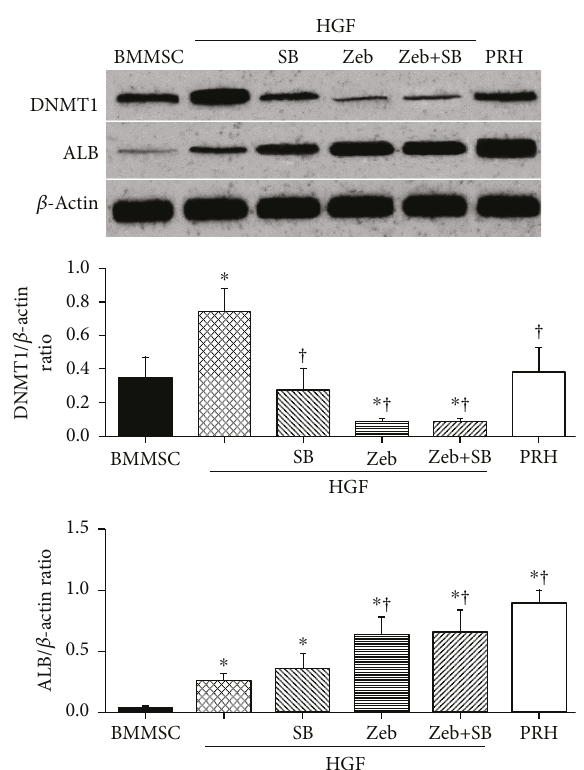
Figure 4: Zebularine and SB203580 inhibited expression of DNMT1 and upregulated expression of ALB in BMMSCs. Noninduced BMMSCs and primary rabbit hepatocytes (PRH) were used as negative or positive controls. HGF increased the expression of DNMT1. HGF-induced expression of DNMT1 was inhibited by zebularine and SB203580. ALB protein expression was regulated by SB203580 and zebularine. The peak of expression of ALB in the induced groups was lower than that in primary rabbit hepatocytes. Asterisk indicates p < 0 05 compared with the control group; dagger indicates p < 0 05 compared with the HGF